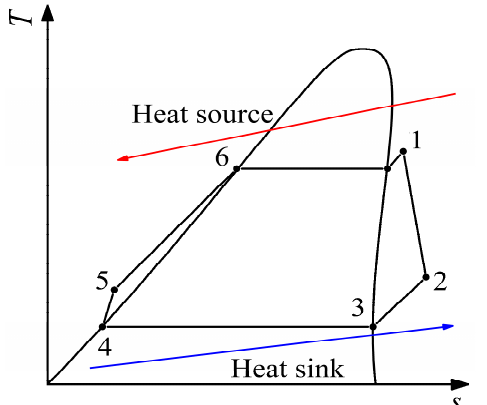
Figure 8. T -s diagram of simple ORC system. 1–2 presents the expansion process; 2–3–4 presents the